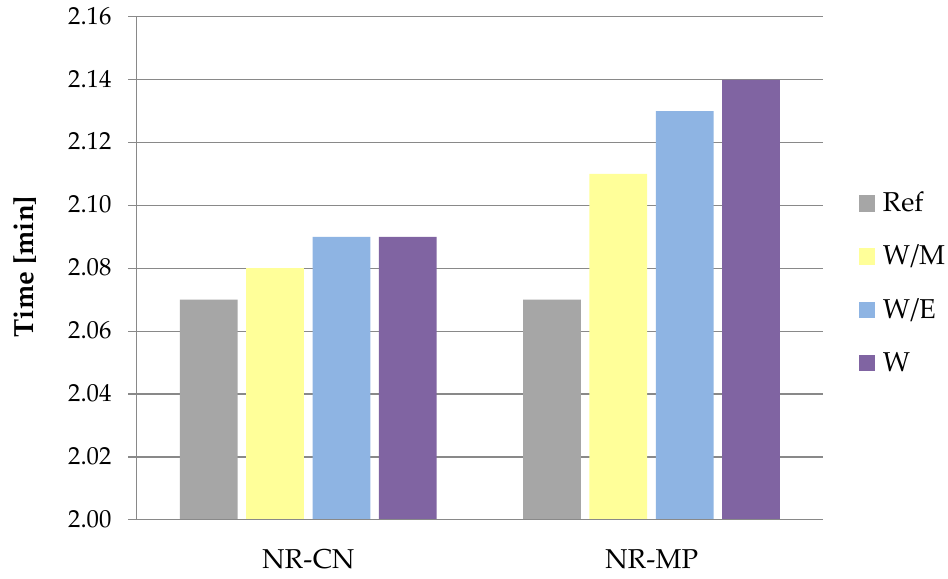
Figure 7. Optimal vulcanization time (t 90 ) of vulcanizates.